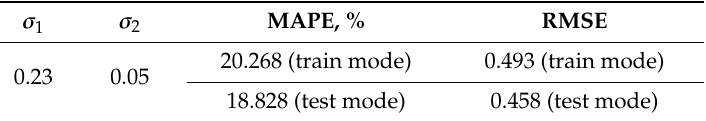
Table 3. Optimal parameter of proposed ensemble operation.